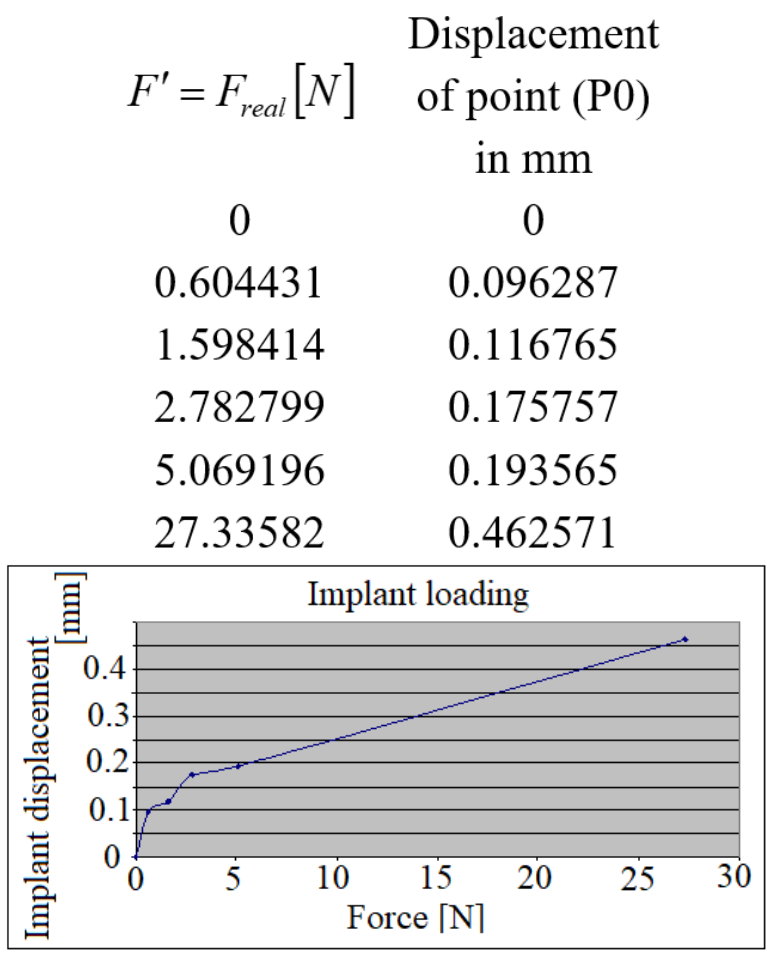
Figure 5. The implant’s displacement during its loading.